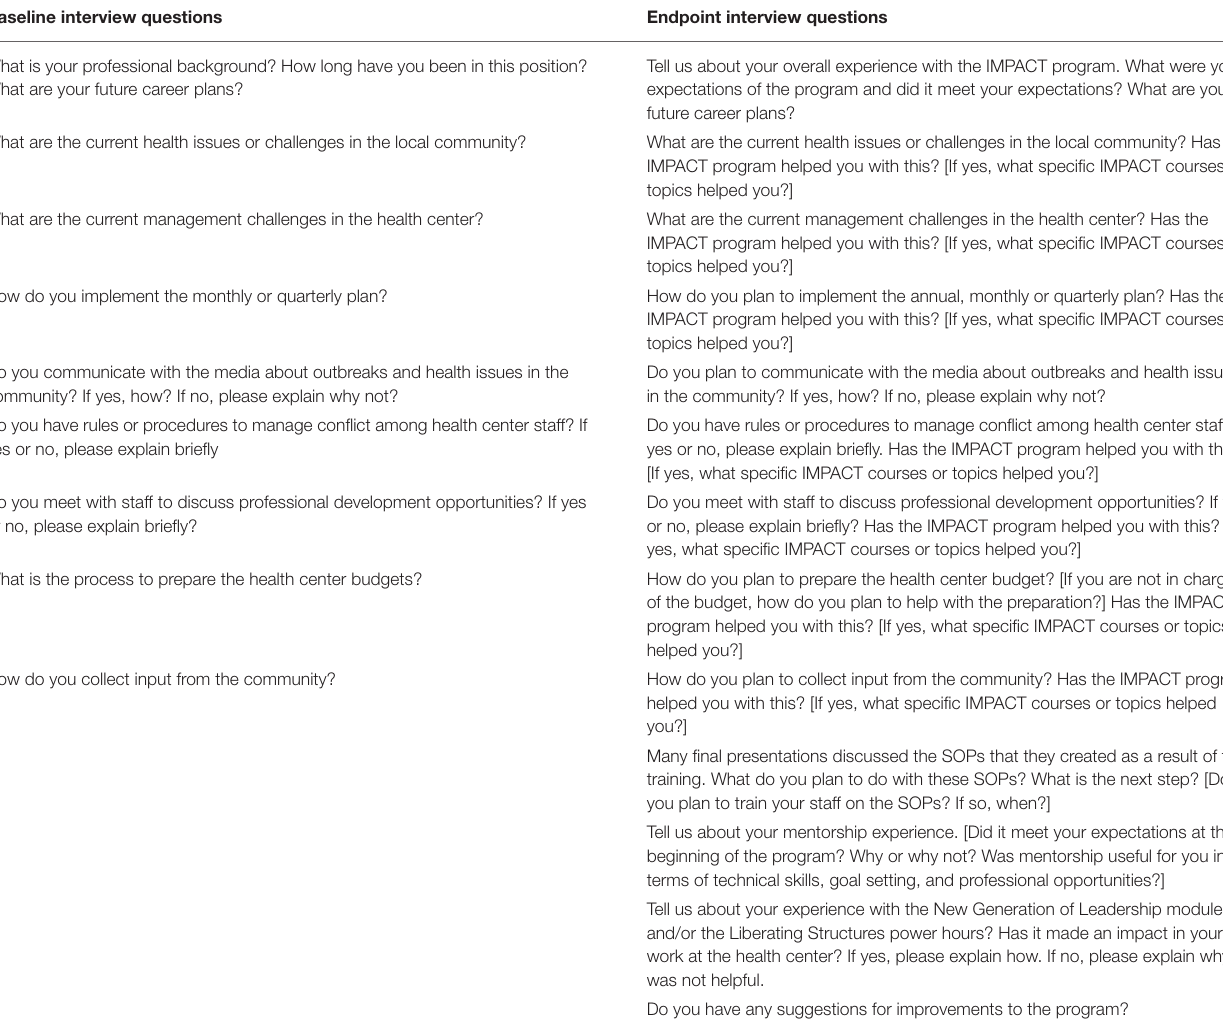
TABLE 4 | Questions asked during semi-structured interviews with IMPACT Cambodia participants, at baseline and